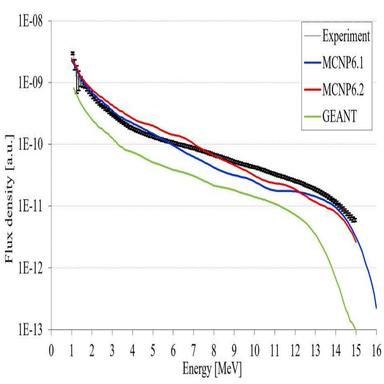
Comparison of calculated and evaluated neutron spectra with marked uncertainties 1 m from characterized liquid water target normalized per 1 proton emitted from accelerator. The calculational uncertainties are not plotted, as they are comparable with experimental uncertainties.